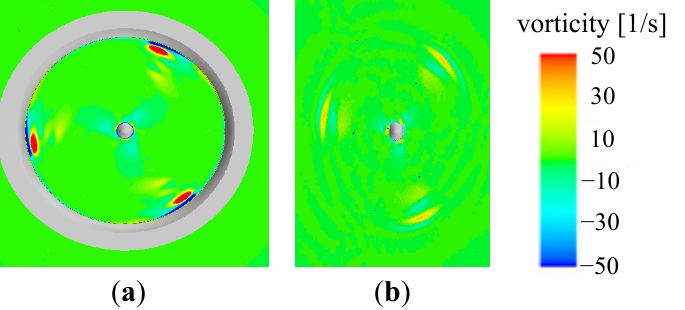
Figure 14. Comparison of the x -component of the vorticity in r - θ cross-sections between ( a ) the compact-type Wind-Lens turbine; and ( b ) the bare wind turbine at x = 0.2 m = 0.08 D . vorticity [1/s]